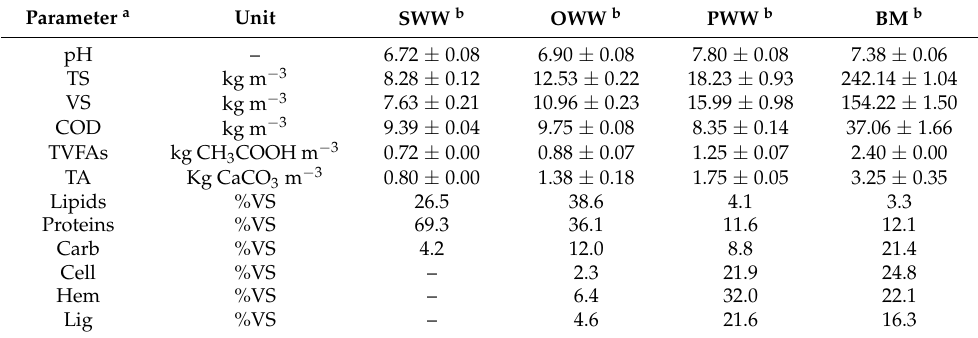
Table 2. Characteristics of slaughterhouse wastewater streams and BM. Results are reported as an average of three measurements ( ± 95% confidence